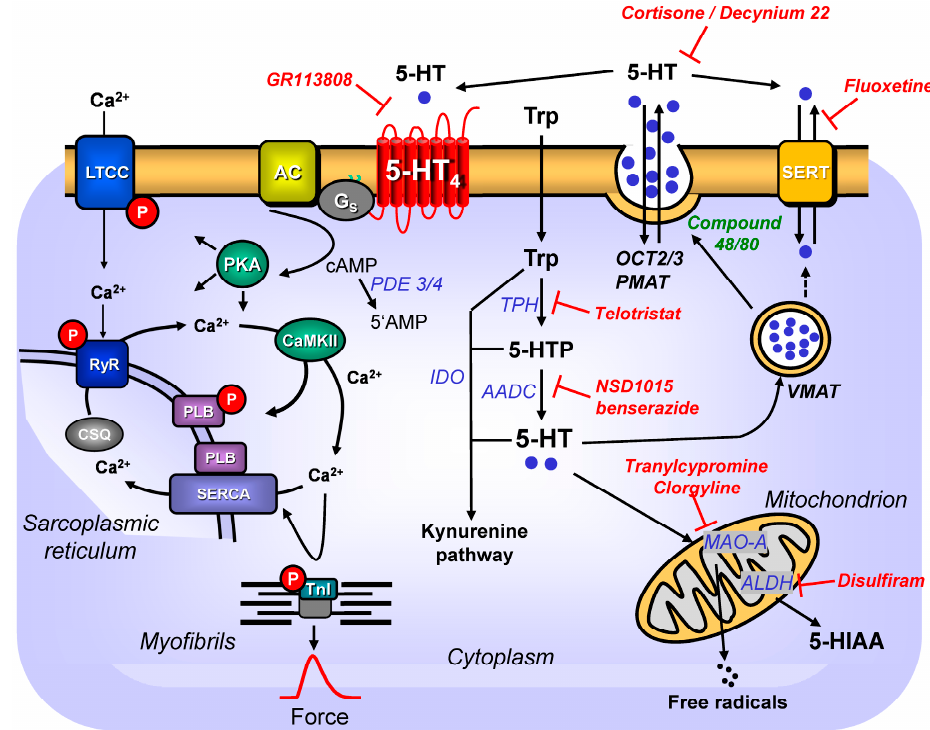
Figure 1. Putative metabolism of serotonin in the heart. Activation of 5-HT 4 -receptors (5-HT 4 ) leads to stimulatory guanosine triphosphate proteins (Gs) and increases the activity of adenylyl cyclases (AC5/6). This stimulation is antagonised by, e.g., GR 113808. More 3 ′ ,5 ′ cyclic adenosine monophosphate (cAMP) is formed that activates the cAMP-dependent protein kinases (PKA). This leads to the phosphorylation and activation of L-type calcium channels (LTCC) in the sarcolemma, of the ryanodine receptors (RYR), phospholamban (PLB, on amino acid serine 16) and the inhibitory subunit of troponin (TnI). Calcium ions enter the cytosol from the LTCC or via the RYR. In cytosol, calcium ions bind to myofilaments, which enhances force generation. Calcium ions also activate a calcium and calmodulin protein kinase (CaMK) that likewise phosphorylates RYR and PLB (on amino acid threonine 17). The generated cAMP in the heart is mainly degraded by phosphodiesterase (PDE) 3 or 4. Calcium ions in the sarcoplasmic reticulum (SR) are stored by binding to calsequestrin (CSQ). Calcium is pumped back from the cytosol by SR-Ca-ATPase (SERCA). The activity of SERCA is impaired by PLB and enhanced by phosphorylated PLB. Tryptophan (Trp) enters the cardiomyocyte where it is hydroxylated by tryptophan hydroxylase 1 (inhibitable by, e.g., telotristat) to 5-hydroxy-tryptophan (5-HTP). 5-HTP can then be decarboxylated by amino acid decarboxylase (AADC, inhibitable by NSD 1015 or benserazide) to serotonin (5-HT). Alternatively, tryptophan can be metabolised by indole amine dioxygenase (IDO) and enters the kynurenine pathway. 5-HT can be oxidated by mono amine oxidases (MAO-A, inhibitable by clorgyline or tranylcypromine) located in the outer membrane of mitochondria. Thereafter, the products can be further degraded by an alcohol dehydrogenase (inhibitable by disulfiram). 5-HT can be transported into storage vesicles via a vescular mono amine transporter (VMAT). 5-HT can exit the cell via serotonin transporter (SERT, inhibitable by fluoxetine) or via OCT or PMAT (inhibitable by cortisone or decynium 22).